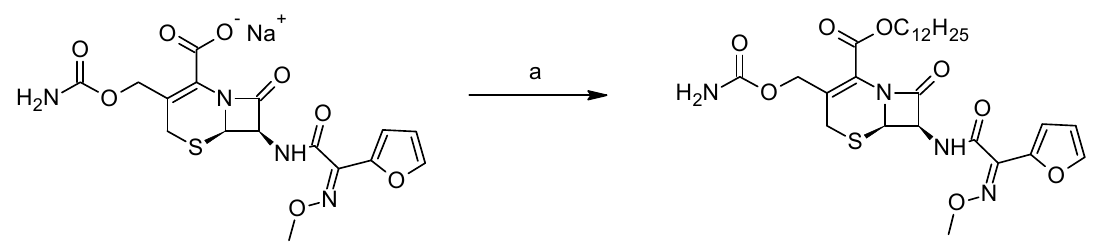
Figure 2. dCEF synthesis scheme: ( a ) n-dodecan-1-ol, HBTU, DMF, 25 °C, 18 h.